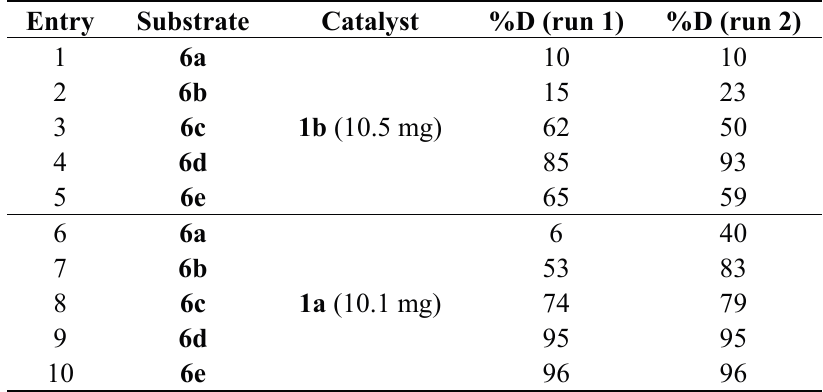
Table 3. Deuteration of Esters 6a – e